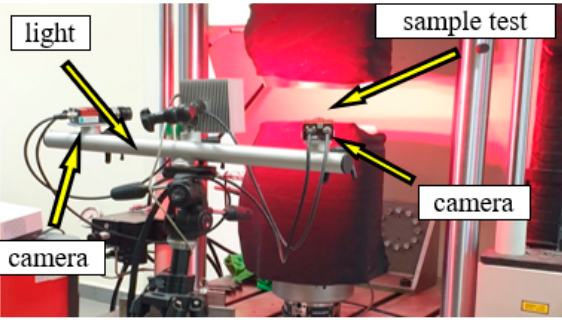
Figure 4. Digital image correlation measurement system from Dantec.